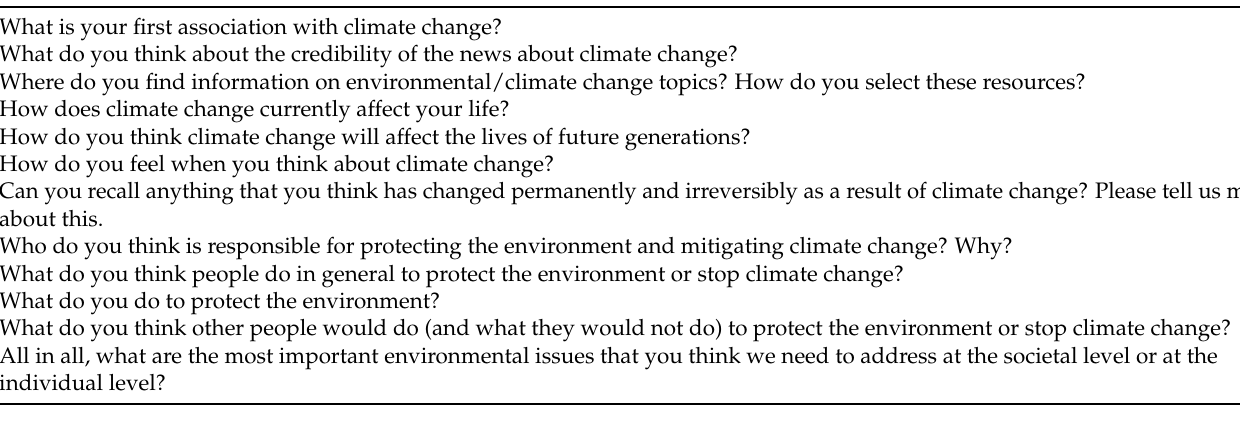
Table A1. The questions of the interview.